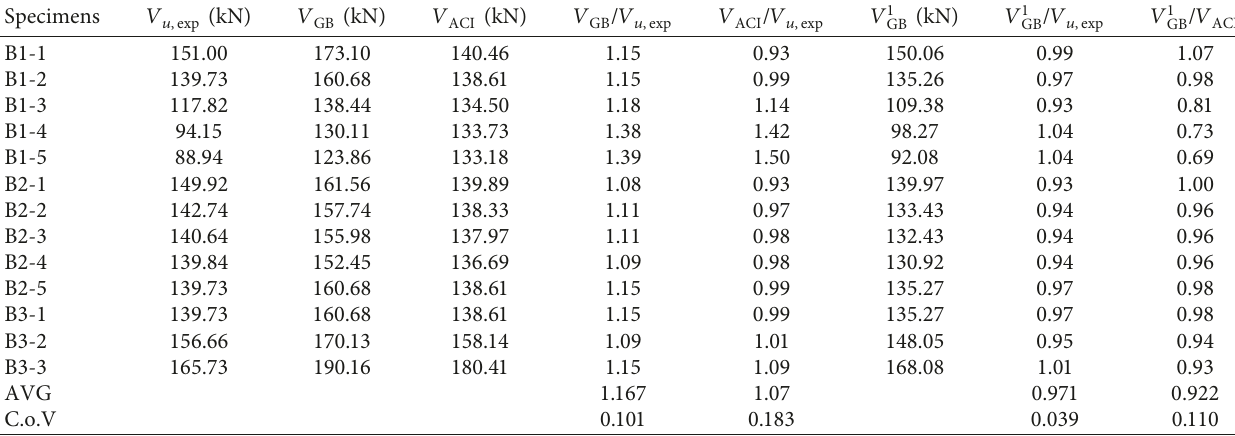
Table 6: Comparison of test results with the calculated values by current design codes.